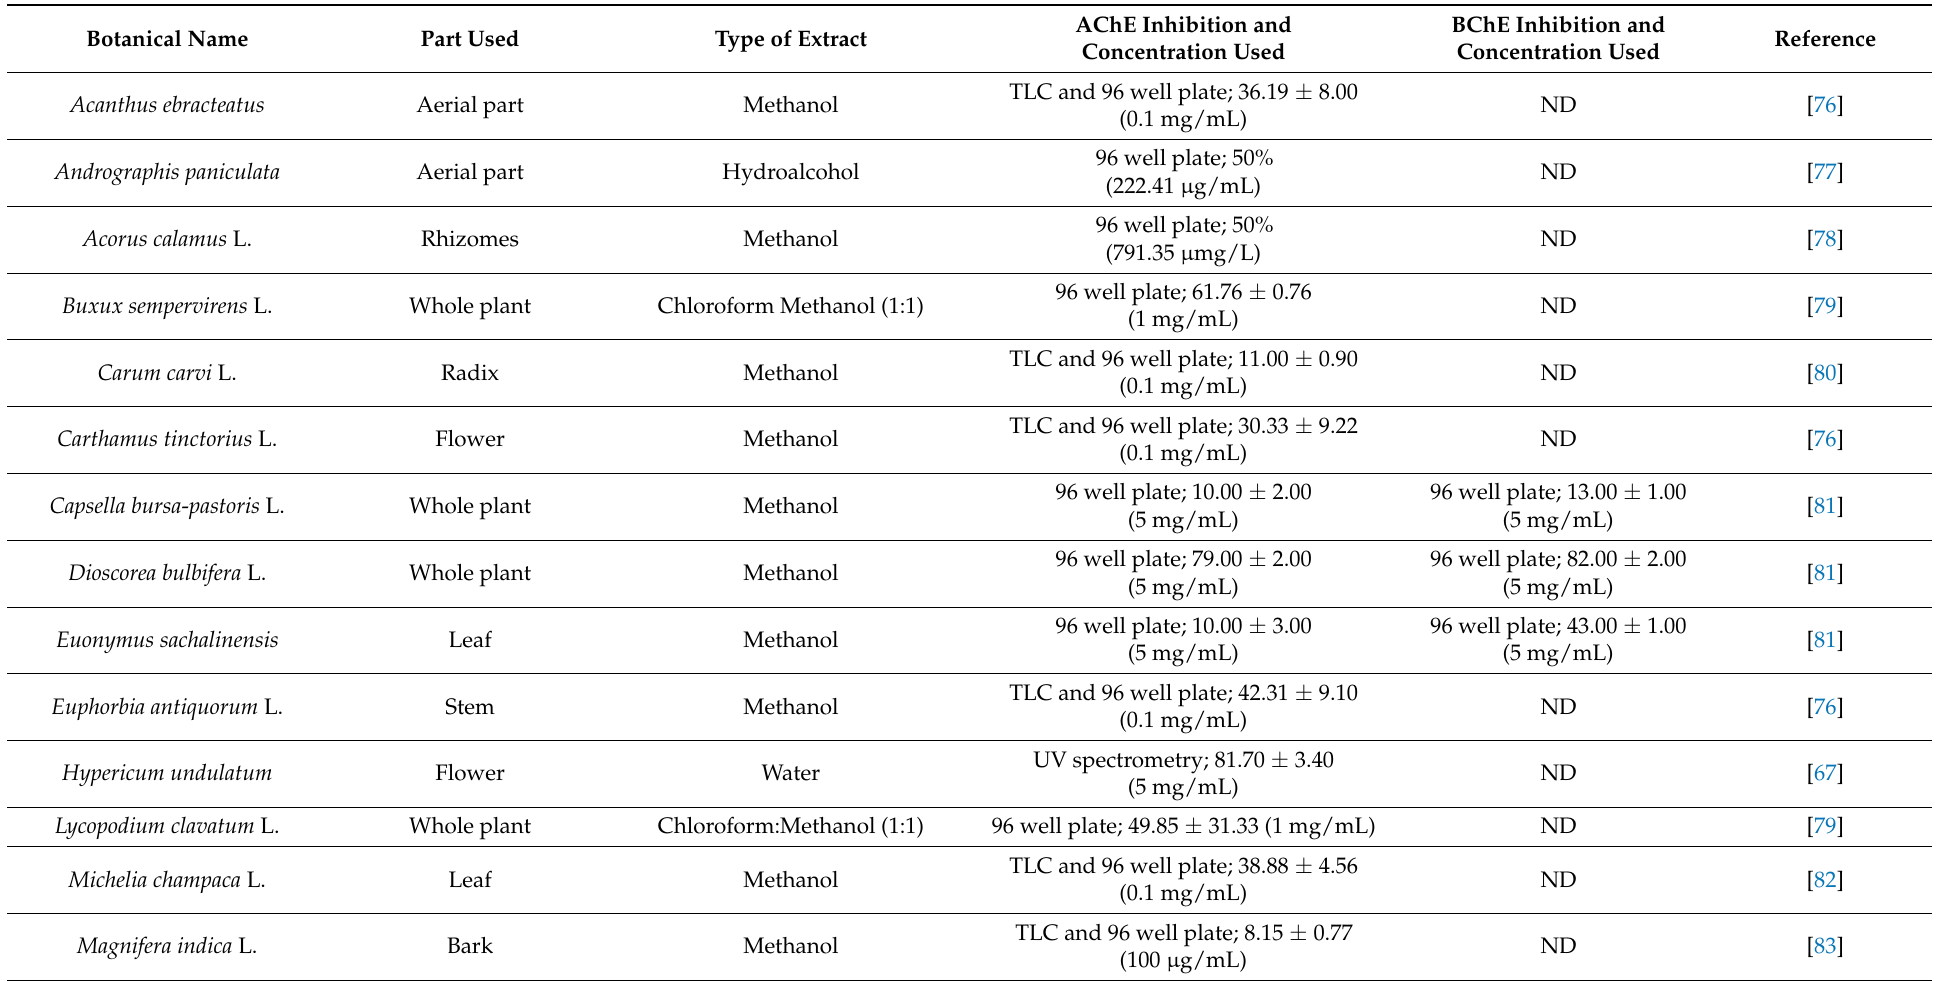
Table 3. Cholinesterase Inhibitory Activity of Different Plant